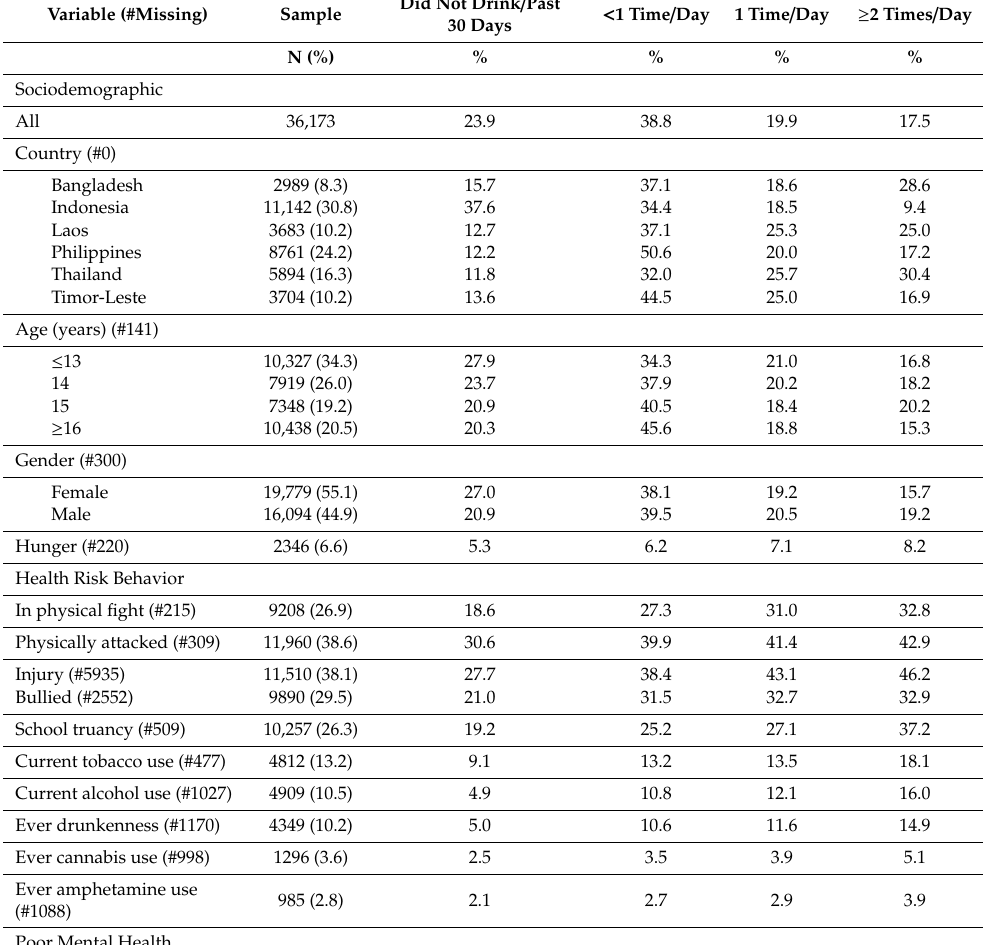
Table 2. Sample characteristics among adolescents in six Southeast Asian